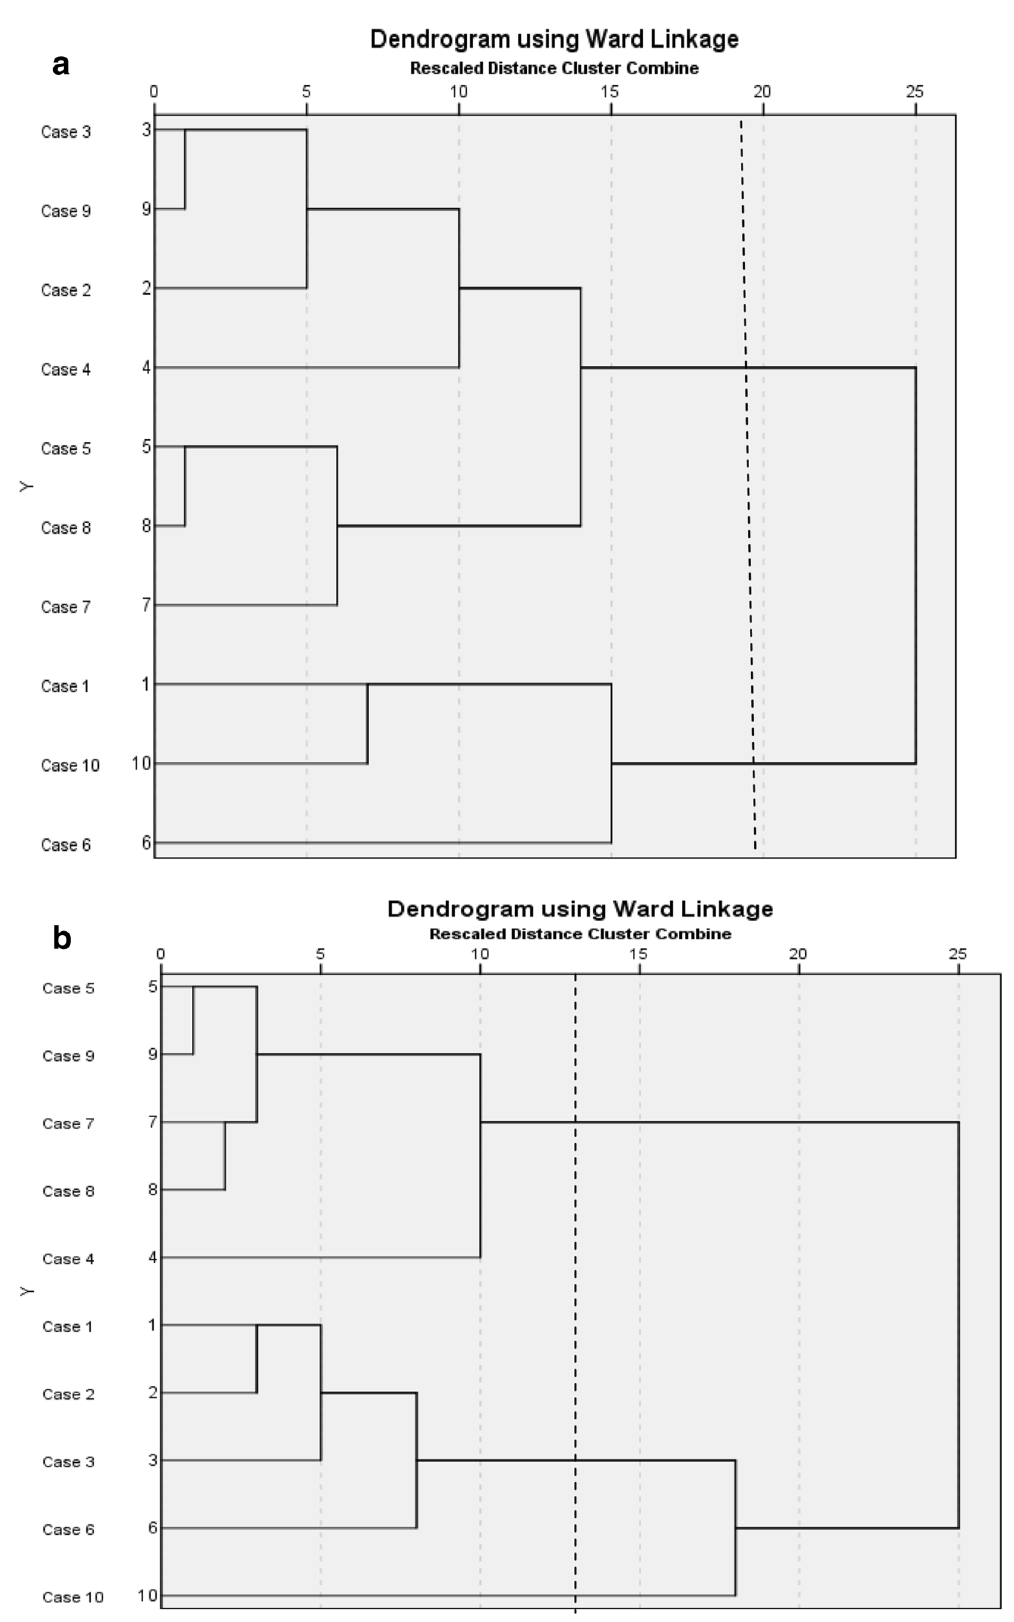
Fig. 6 a Dendrogram of water sampling locations during dry season. b Dendrogram of water sampling locations during wet